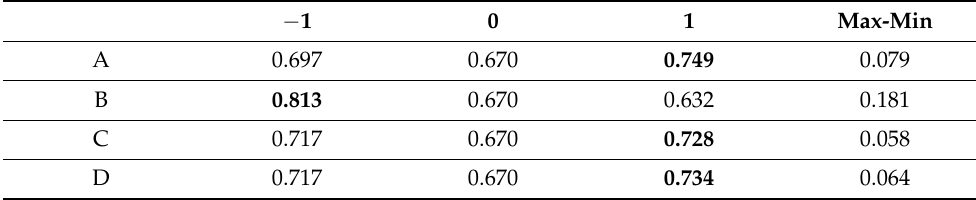
Table 9. Response table for Grey relational